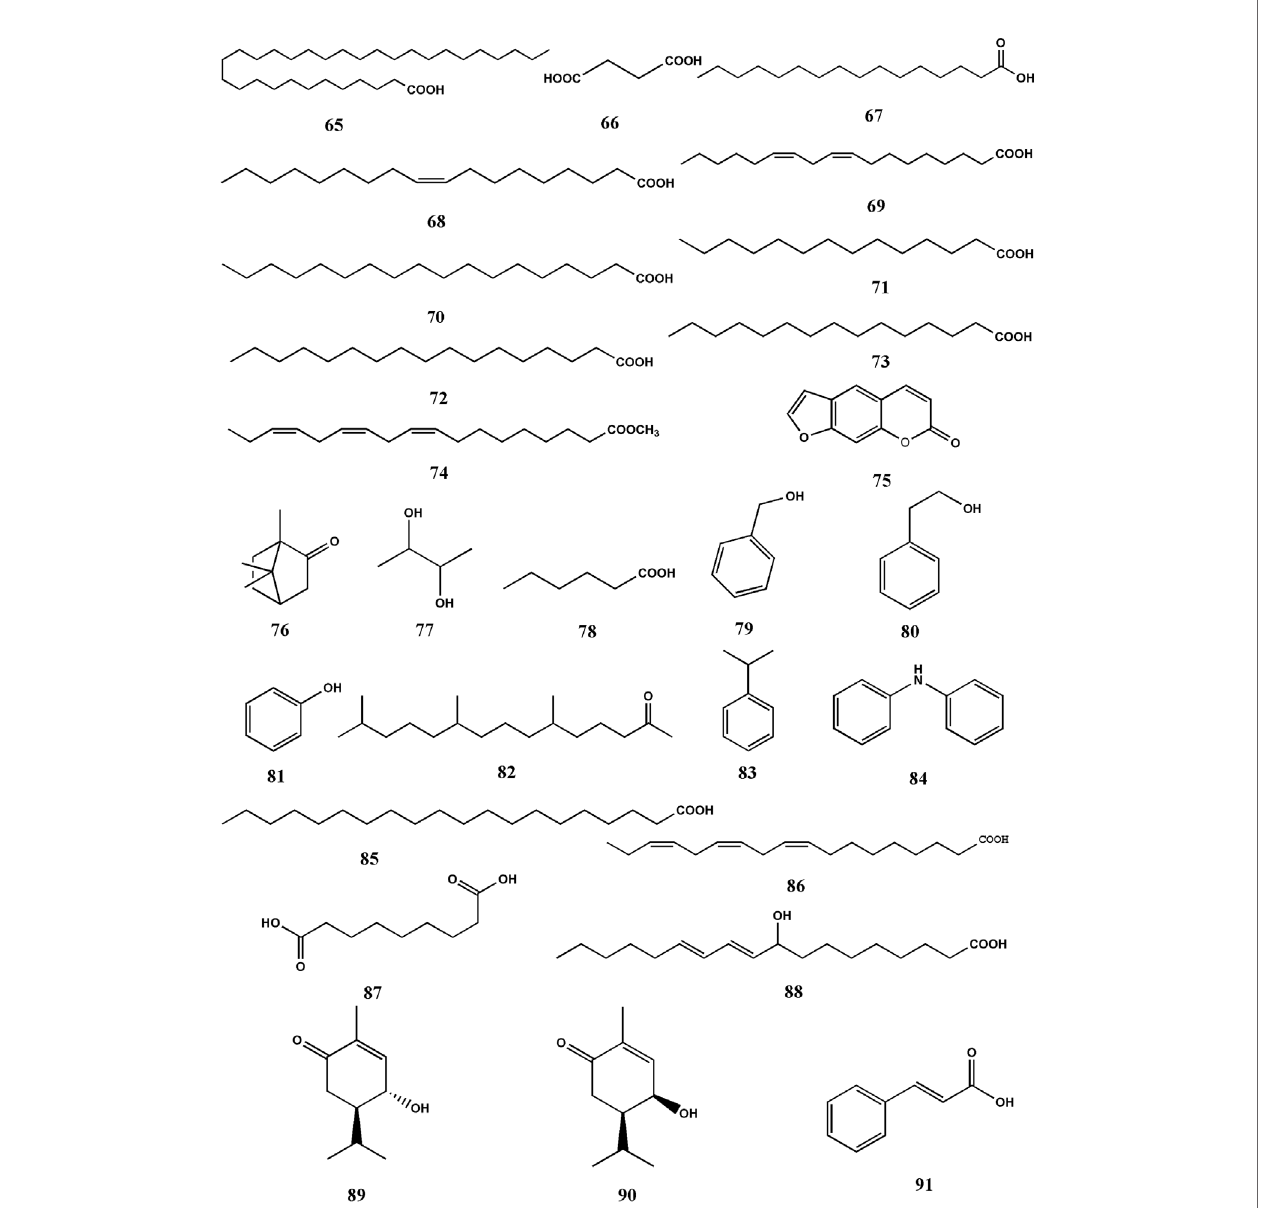
FIGURE 5 | Structures of volatile oil and fatty acids from Tetrastigma hemsleyanum Diels &